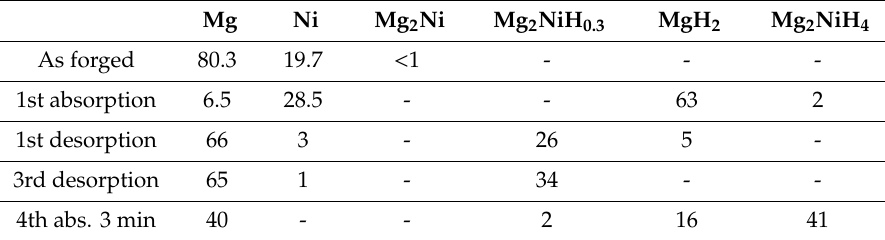
Table 1. Weight fraction (%) of phases observed in samples forged at room temperature.